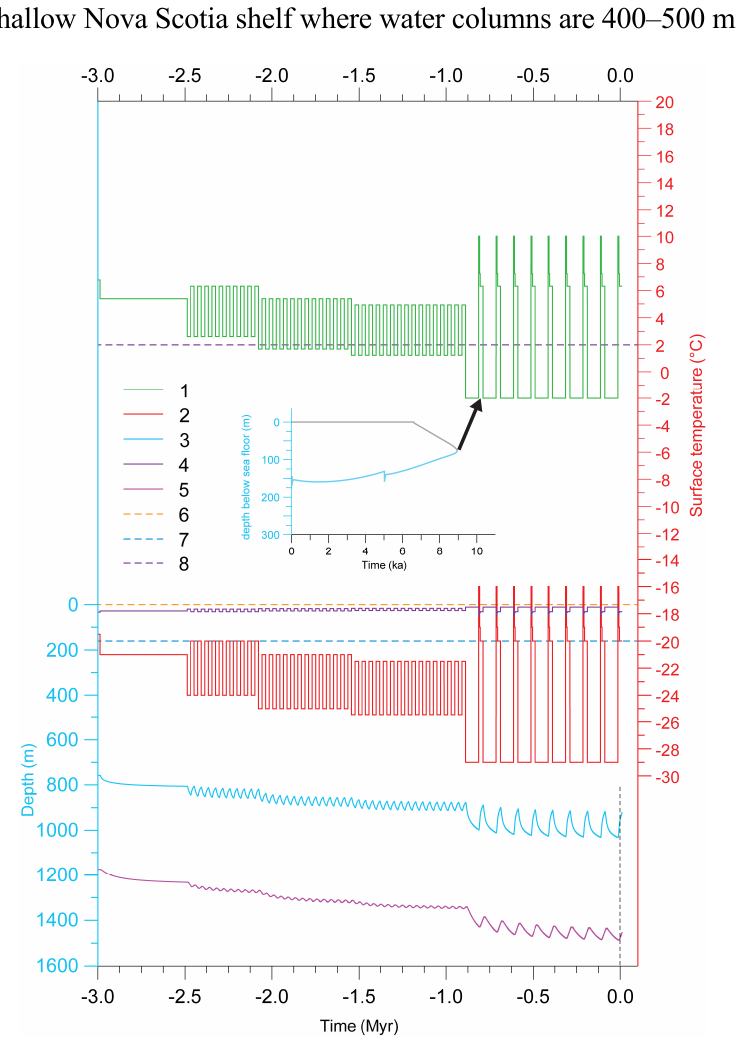
Figure 20. Comparison of the GH models for illustrated climate histories for both (1) the Canadian offshore vs. (2) the Canadian Arctic history. Curves 3 and 4 illustrate the top and bottom of the onshore Arctic GHs from [9], respectively. Curves 6 and 7 illustrate the GH layer top and bottom (below sea level) for a typical marine gas hydrate. Curve 8 illustrates the average sea bottom temperature required for GH stability below a 400 m water column assuming an average marine heat flow. The insert illustrates the GH layer top and bottom history for the shallow Nova Scotia shelf where water columns are 400–500 m thick